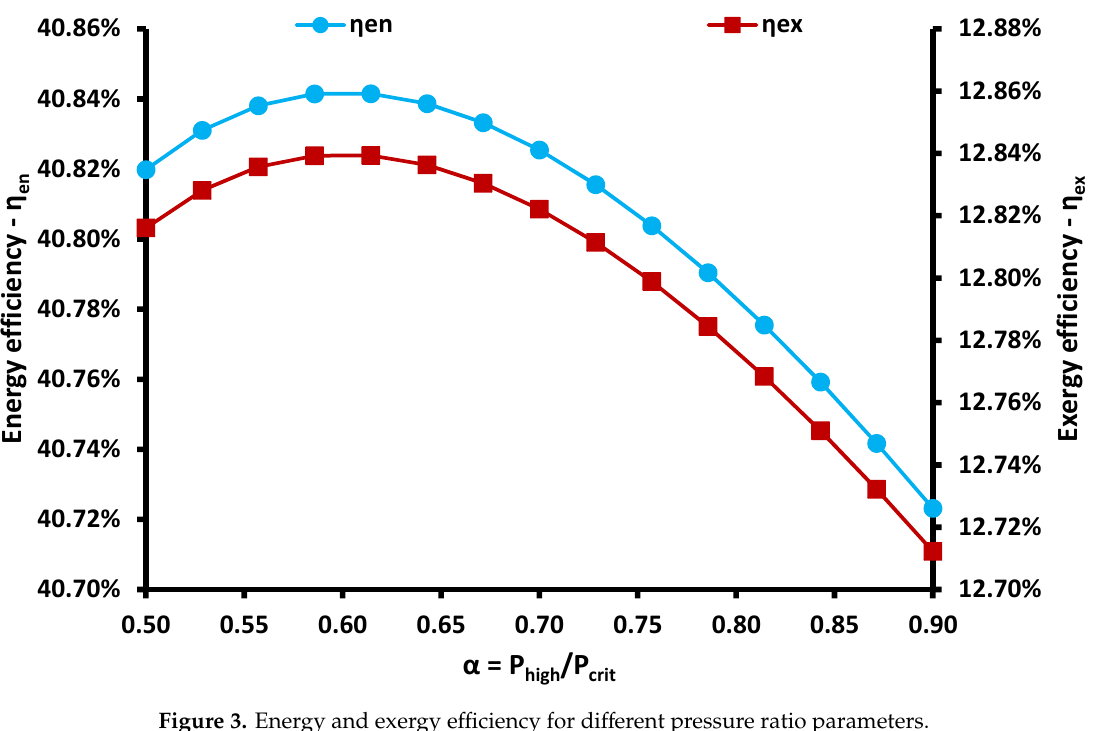
Figure 3. Energy and exergy efficiency for different pressure ratio parameters.